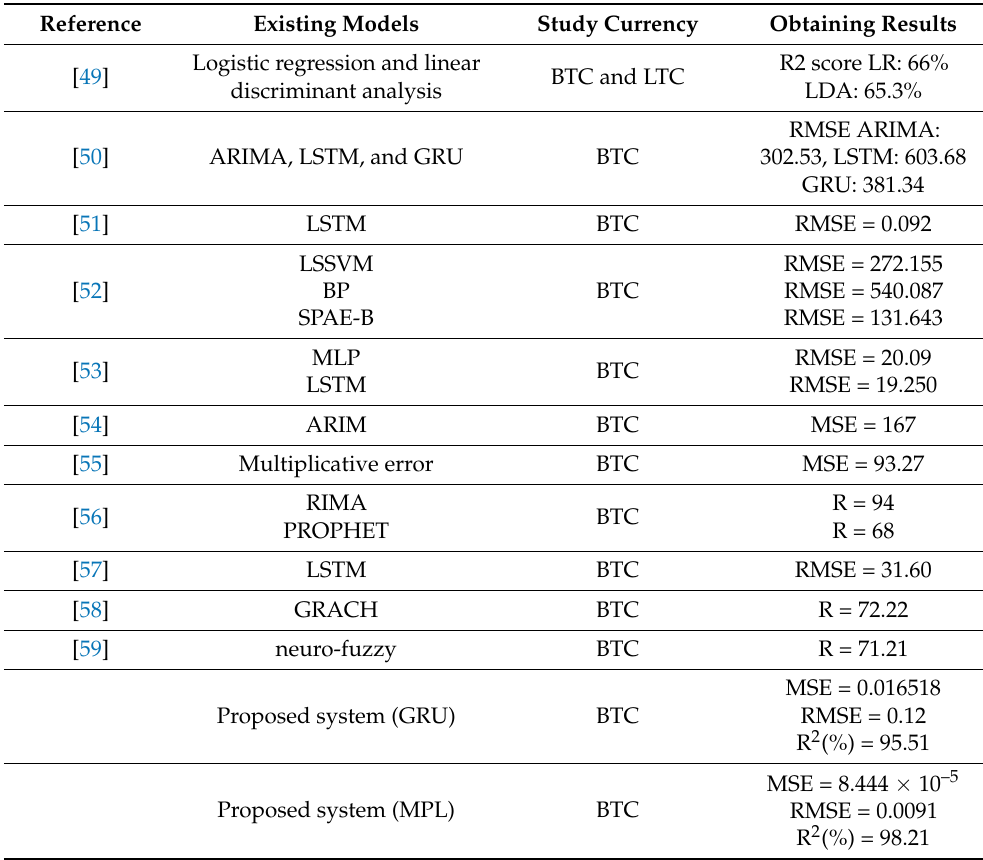
Table 4. Comparison results between the proposed system and the existing